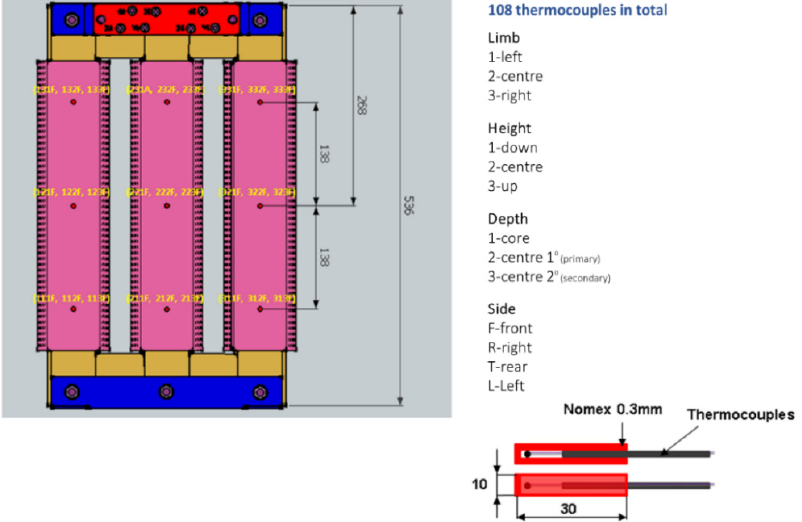
Figure 2. Temperature sensors, including the notation nomenclature for each of the sensors.